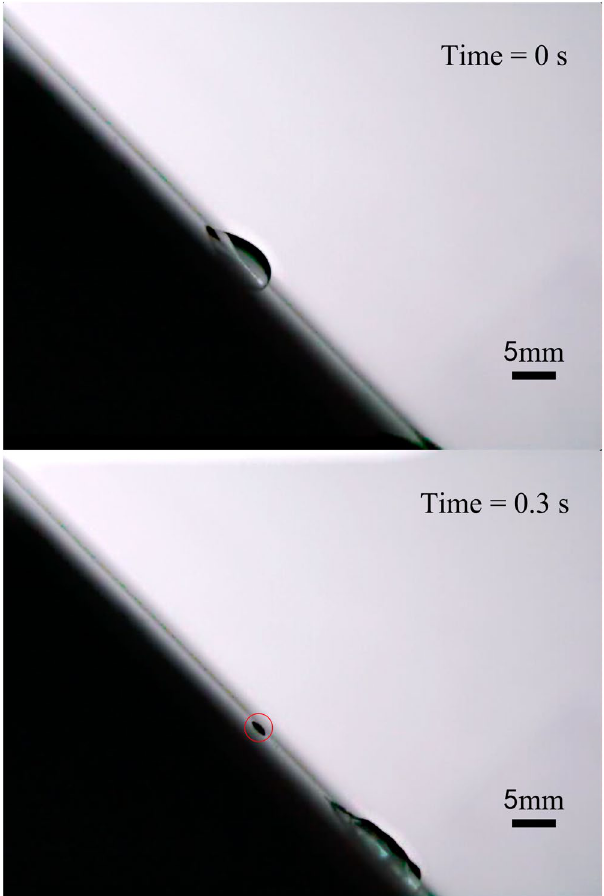
Figure 3. 30 μ l droplet movement induced by 1 MHz Lamb waves at inclination of the plate 45°. The place of the dropped pearls is at the position of droplet’s advancing end of initial